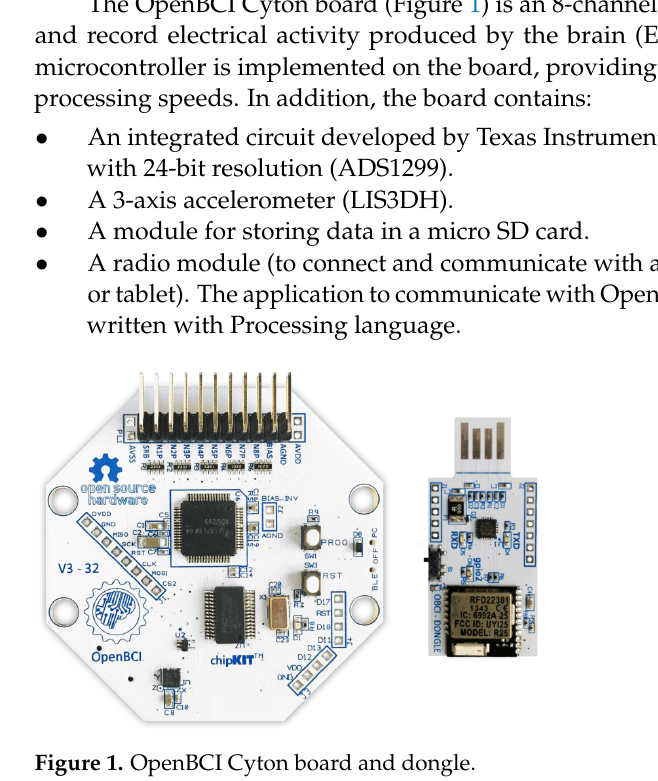
( b ) Figure 2. ( a ) Flexible gold cup electrode array; ( b ) Placement of the flexible gold cup electrode array behind the ear. The electrode array is held in the right place by two elastic fabric strips. 2.1.2. MAX86150 Maxim Integrated ʹ s MAX86150 biosensor module [64] offers PPG and ECG measure ‐ ments in a single integrated package with 16 ‐ bit resolution. The MAX86150 module com ‐ bines internal LEDs, photodetectors, and an ECG Analogue Front ‐ End (AFE) to provide highly accurate, low ‐ power PPG and ECG signals acquisition. It was chosen because of its small dimensions (3.3 mm × 5.6 mm × 1.3 mm) and because it is capable of performing Channel 1 Channel 2 Reference and noise ‐ cancelling Channel 3